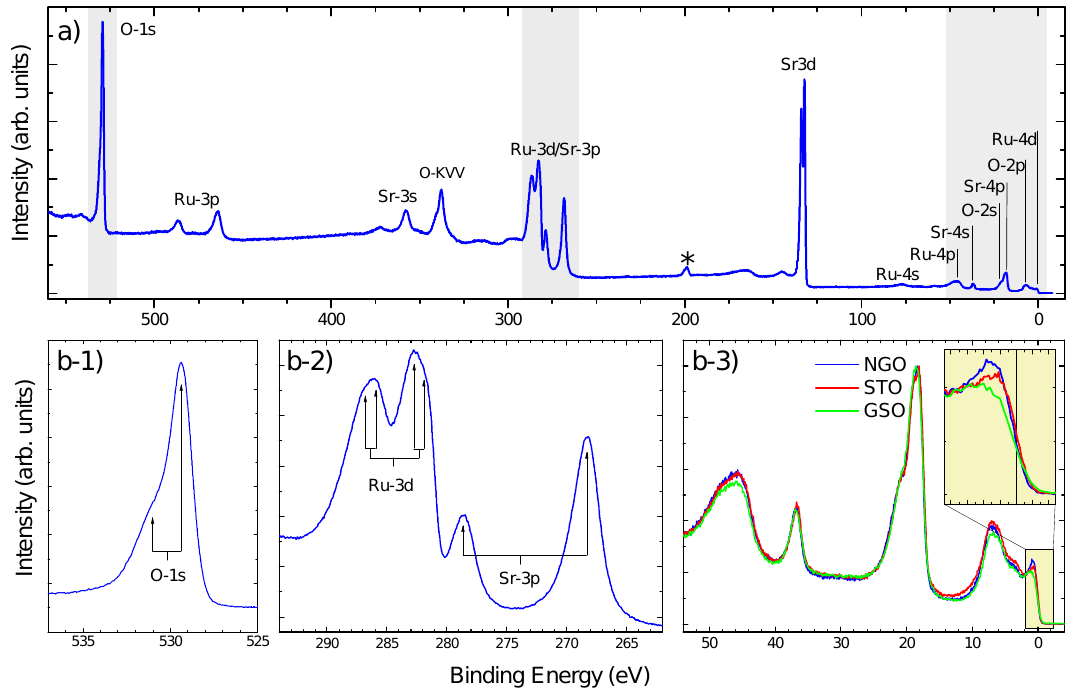
Figure 6. ( a ) XPS survey scan of a SRO film grown on NGO substrate (excitation photon energy was h ν = 850 eV); ( b ) high-resolution XPS scans of O-1s ( b-1 ) and Ru-3d/Sr-3p ( b-2 ) core levels, along with the valence band ( b-3 ); In particular, valence band scans are reported for all of investigated SRO samples (i.e., namely grown on NGO (blue), STO (red) and GSO (green), respectively; in the inset, a zooming out of the Fermi’s